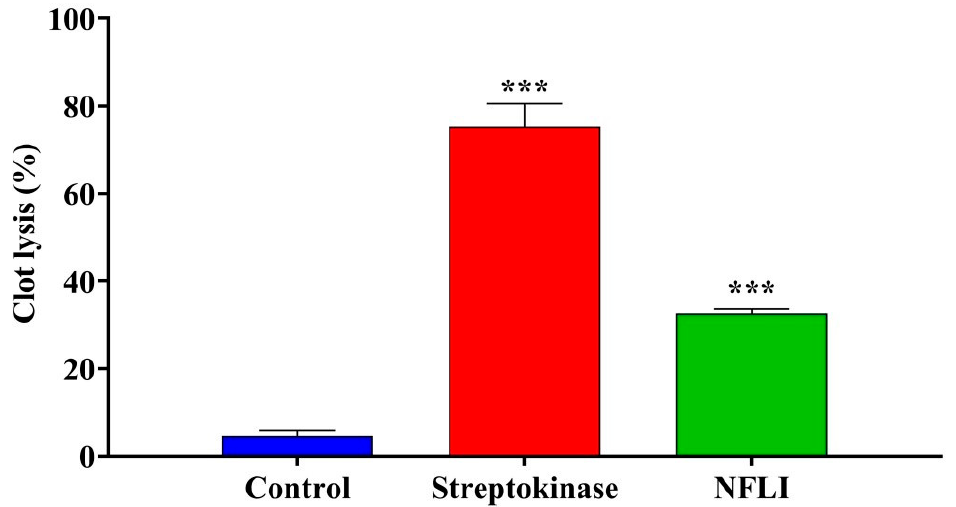
Figure 2. Thrombolytic activity of the n -hexane fraction of L. indica (NFLI) compared with streptokinase. Results are expressed as mean ± SEM, with *** p < 0.001 considered significantly different to the negative control group following one-way ANOVA (Dunnett’s